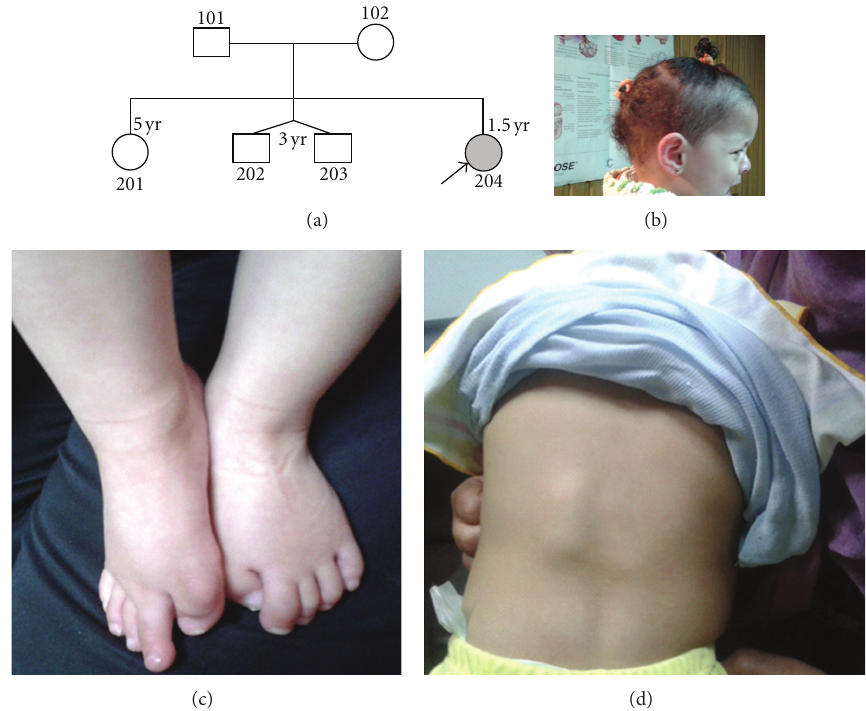
F 1: Clinical data: (a) pedigree of the family showing no consanguinity and no family history, (b) photographic pro�le for the baby’s face showing sparse scalp hairs, (c) photograph for the baby’s feet showing marked shortening, sharpening of both big toes, with hallux valgus deformities, and (d) para-vertebral hard swellings more on the le side.